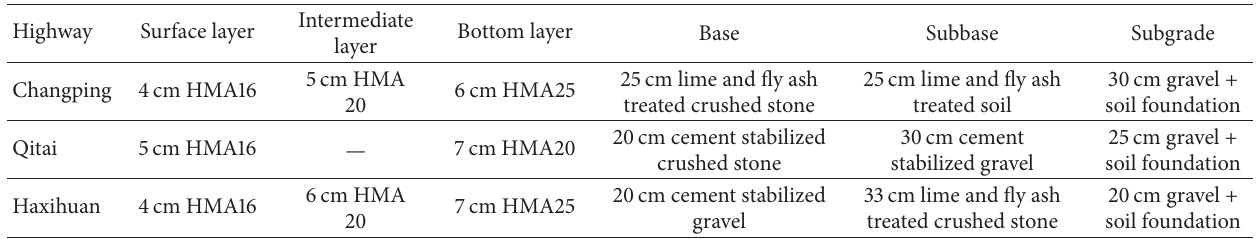
Table 6: Pavement structure and material information for the selected highways.